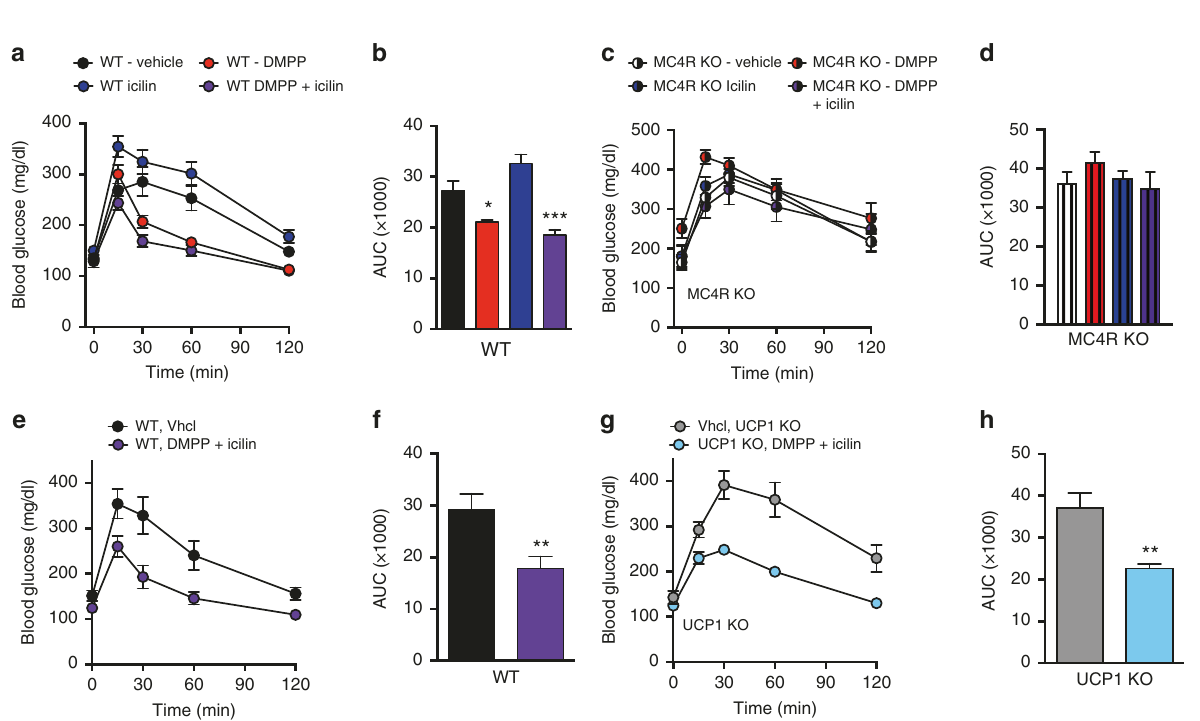
Fig. 7 The melanocortin system is indispensable for the glycemic bene fi ts of icilin and DMPP combination therapy. a and b Effects on glucose tolerance following daily s.c. injections to DIO male C57Bl6j mice or c , d MC4R KO mice of vehicle (black, n = 8/striped white, n = 8), DMPP 5 mg/kg (red, n = 8/ striped red, n = 8), icilin 5 mg/kg (blue, n = 8/striped blue, n = 8), or the combination of DMPP 5 mg/kg and icilin 5 mg/kg (purple, n = 8/striped purple, n = 7) for 7 days. e and f Effects on glucose tolerance following daily s.c. injections to DIO male C57Bl6j mice or g , h UCP1 KO mice of vehicle (black, n = 7/gray, n = 7) or the combination of DMPP 5 mg/kg and icilin 5 mg/kg (purple, n = 7/light blue, n = 7) for 7 days. * p < 0.05, ** p < 0.01, *** p < 0.001 by two-way ANOVA ( a , c , e , g ), one-way ANOVA wit Tukey post-hoc test ( b , d ), or two-tailed Student ’ s t -test ( f , h ). All data are presented as mean ± SEM